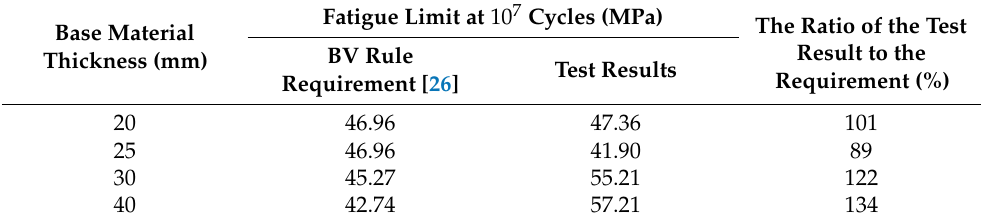
Table 7. Fatigue test results for different base material